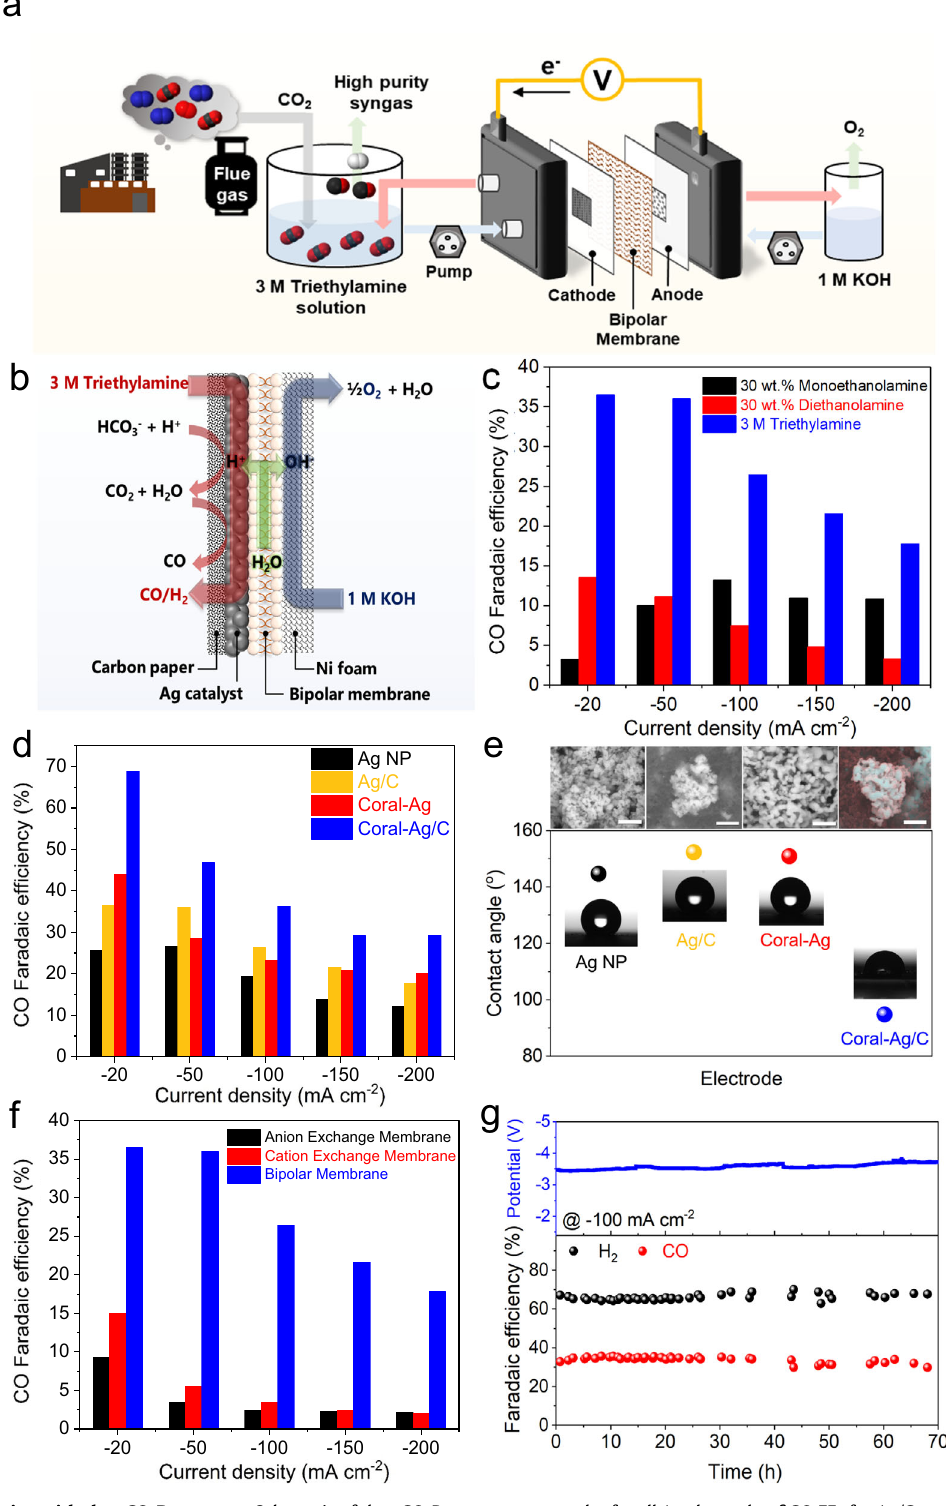
contact angles for all Ag electrodes. f CO FEs for Ag/C measured with various membranes, including ananion exchangemembrane, cationexchange membrane and bipolar membrane, in 3M TREA. g Long-term CO production represented as the H 2 :COratio, CO FEs, and cellvoltages (blue) for coral-Ag/Cat − 100mAcm − 2 in 3M TREA.